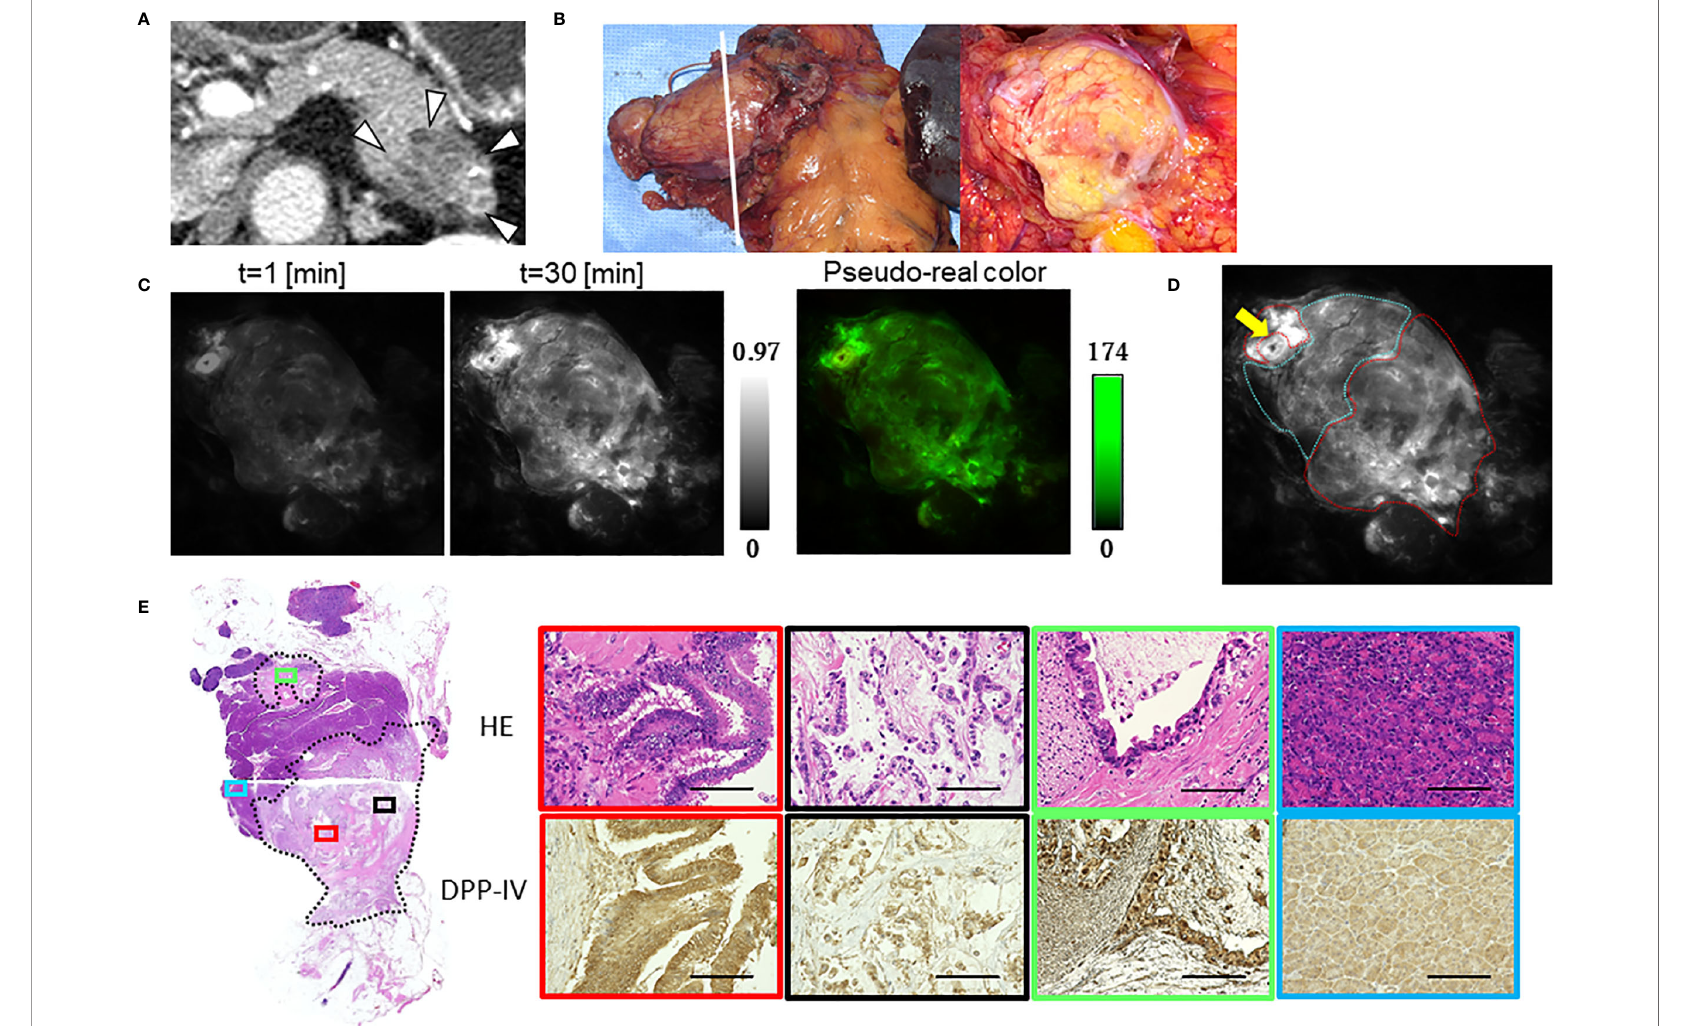
FIGURE 4 | Fluorescence imaging using GP-HMRG to probe whole surgical specimens demonstrates cancer in fi ltration to the splenic artery (Patient No. 8). (A) Preoperative contrast-enhanced computed tomography of pancreatic body cancer (arrowheads). (B) Macroscopic images of the DP specimen (left) and cut surface along the dotted line including the tumor (right). (C) Increase of fl uorescence signals after spraying GP-HMRG on the cut surface and pseudo-real color image at 30 min. (D) Relationships between fl uorescence signals and distributions of cancer tissues (red dotted line) and surrounding pancreatic tissues (blue dotted line) according to histological fi ndings. Arrow indicates the splenic artery. (E) Low-magni fi cation histopathological image of H&E staining corresponding to fl uorescence images (left, dotted line indicates cancer boundaries). Magni fi ed views of H&E staining and IHC analysis of DPP-IV showing fl uorescence (red) and little fl uorescence (black) emitted by parts of the main tumor, viable cancer in fi ltration around the splenic artery (green), and noncancerous pancreatic tissues (blue), (right). Scale bar = 100